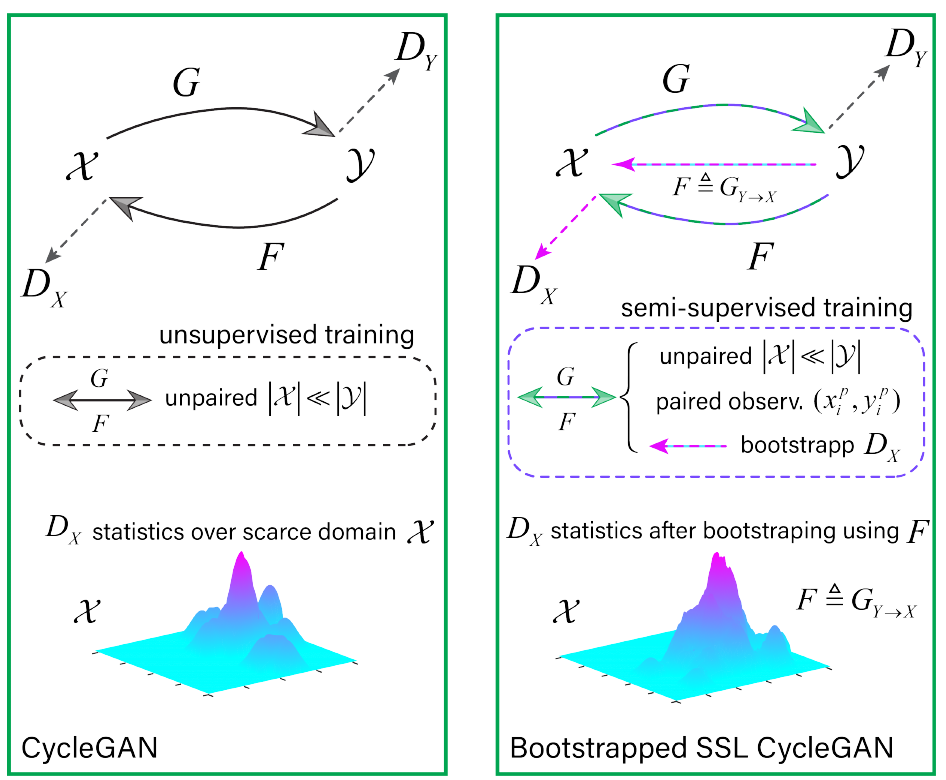
Figure 1. Elements of the proposed SSL method, as compared to the original CycleGAN architecture. It is assumed that one of the domains, e.g., X is scarce, i.e., |X | (cid:28) |Y| , which makes the unsupervised CycleGAN training much harder. Therefore, the proposed BTS-SSL CycleGAN is